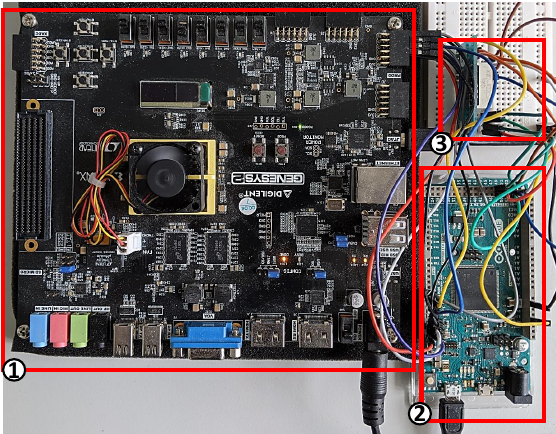
Figure 5: Our prototype: (cid:172) Digilent Genesys 2 FPGA board, (cid:173) Arduino Due as the peripheral simulator, and (cid:174) a seven-segment display unit as an example